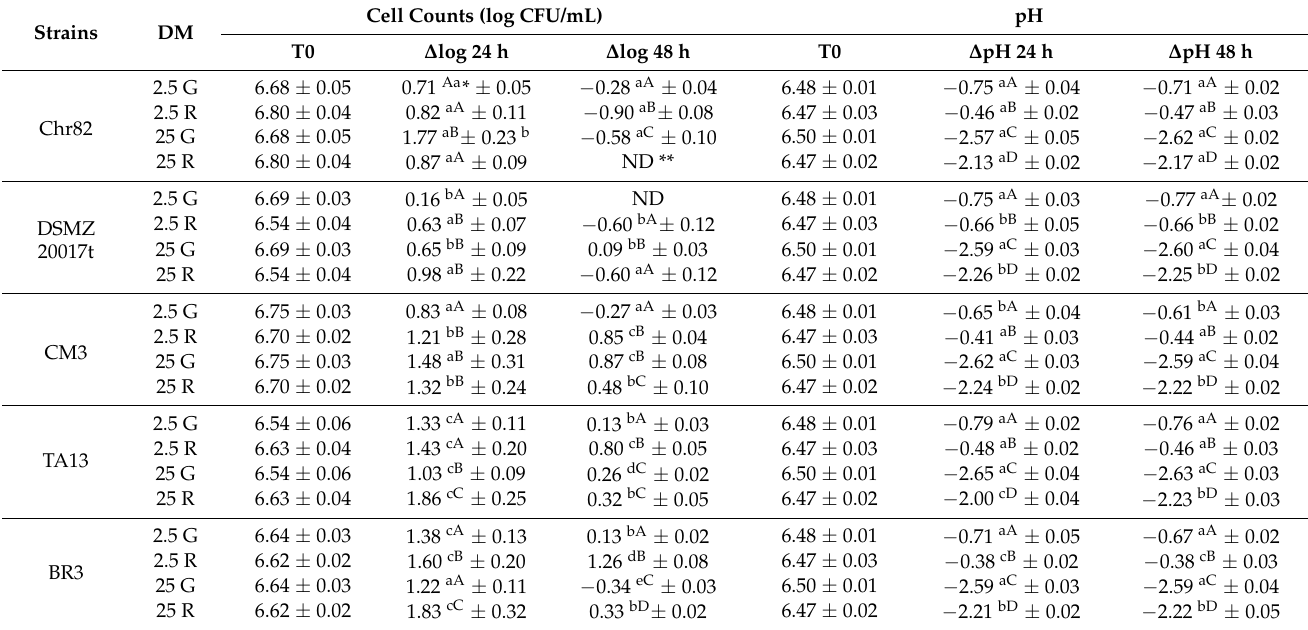
Table 1. Cell counts and pH values observed during the incubation of the five L. sakei strains in the different DM. Data are expressed as variation with respect to the initial values (also reported in the